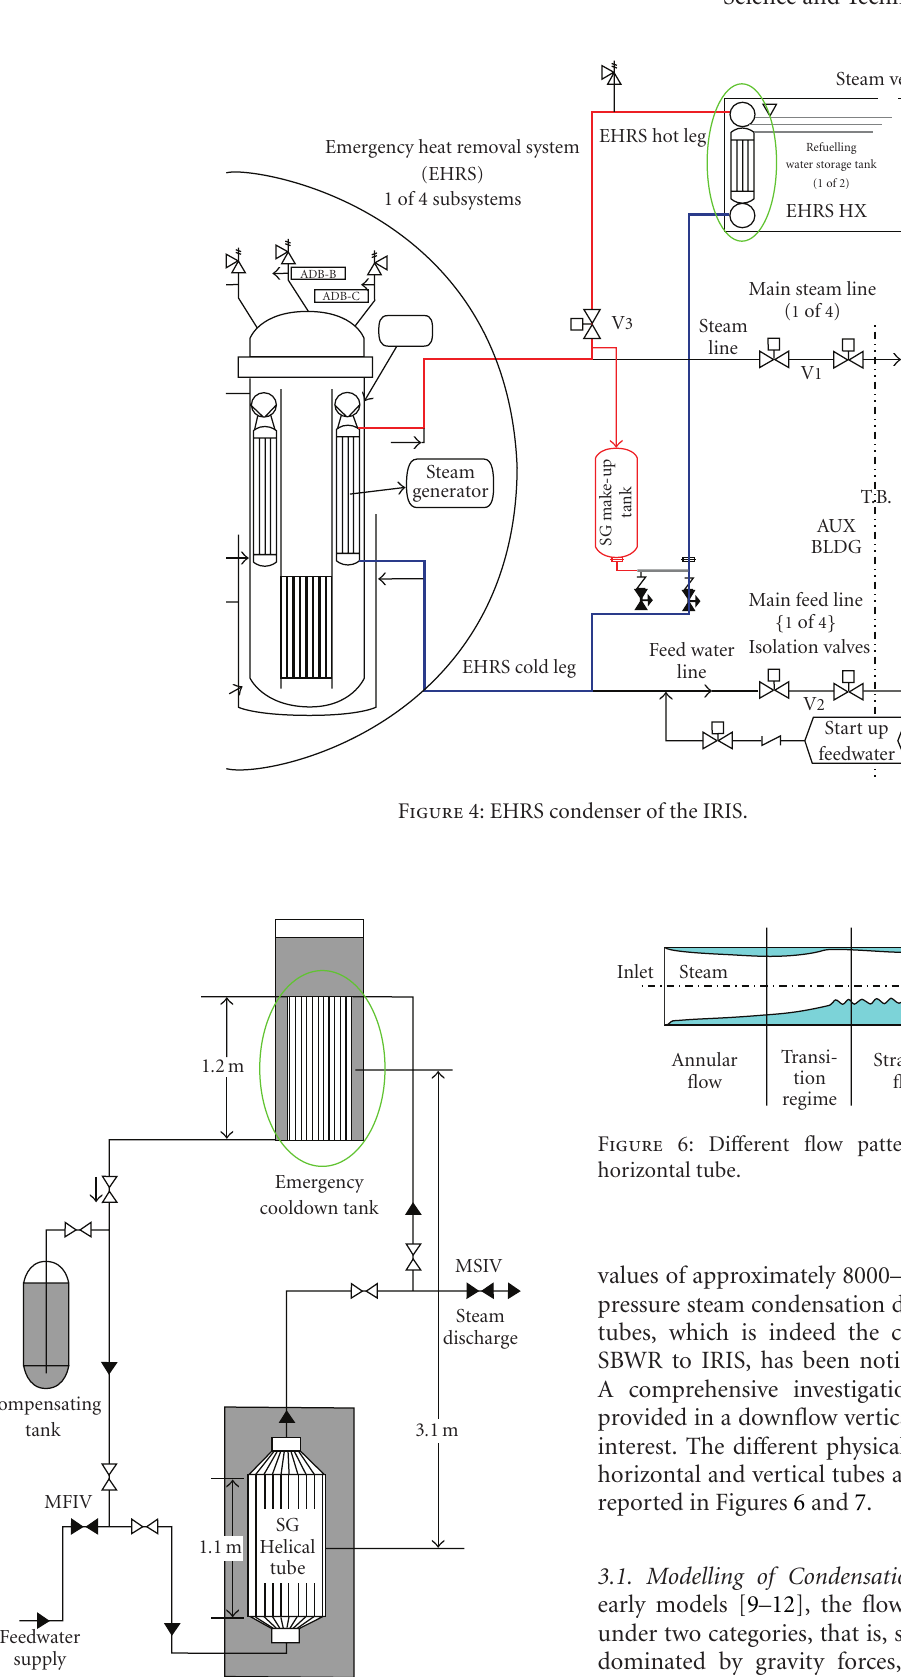
Figure 5: PRHRS condenser of the SMART .